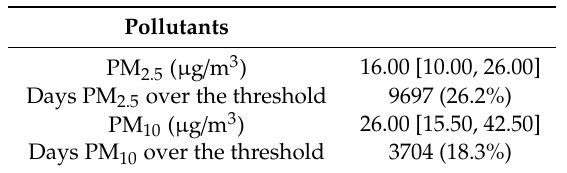
Table 2. Pollutants